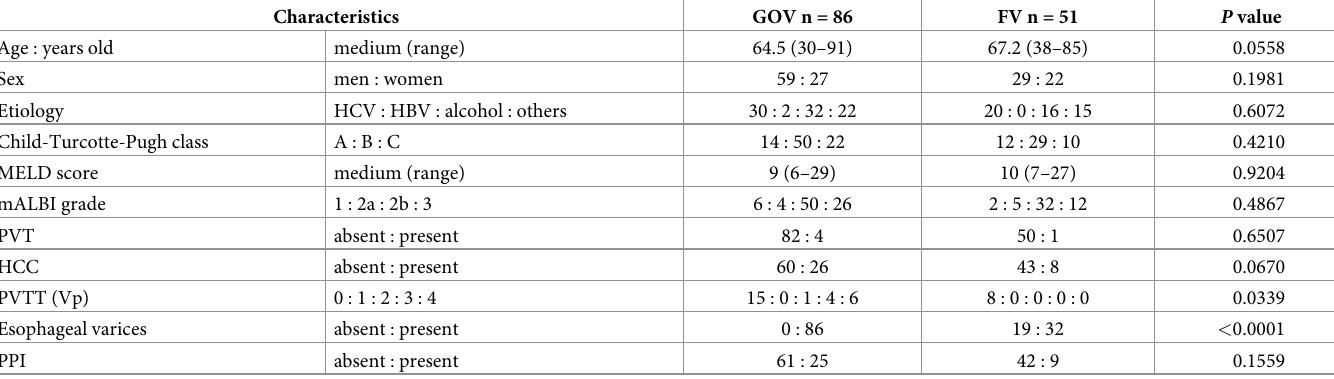
Table 1. Demographic features and clinical characteristics of the 137 enrolled patients with cirrhosis who presented with bleeding gastric varices.